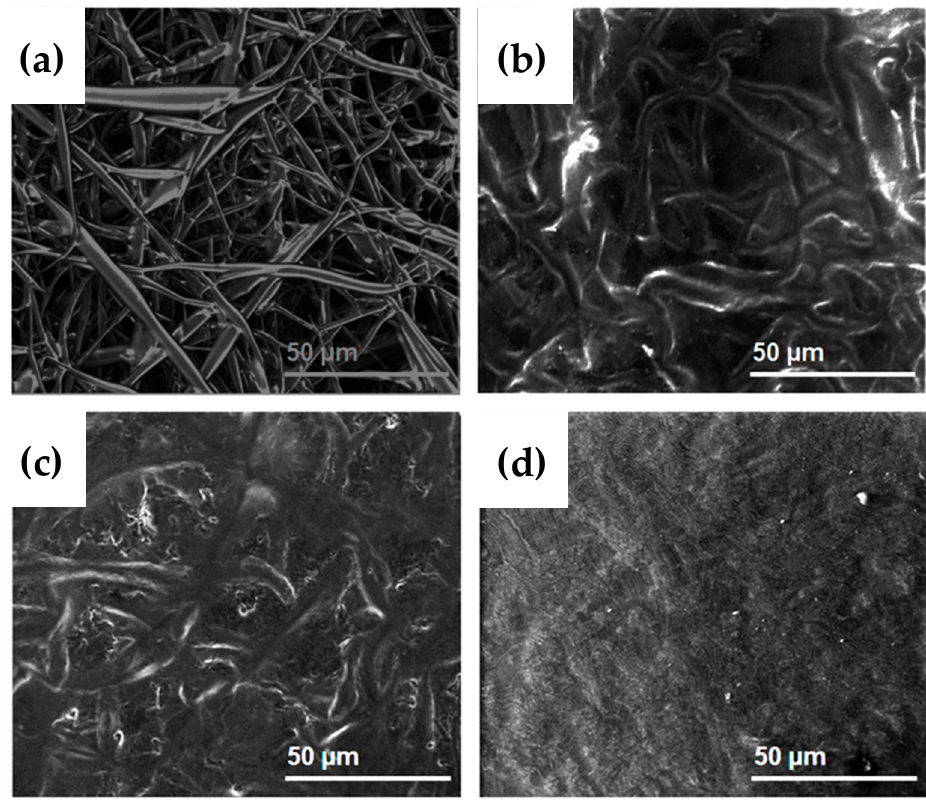
Figure 7. Environmental SEM (ESEM) images of elestrospun asolectin microfiber fibers ( a ), showing its morphology after immersion in PBS for 1 h ( b ), 2 h ( c ) and 4 h ( d ).